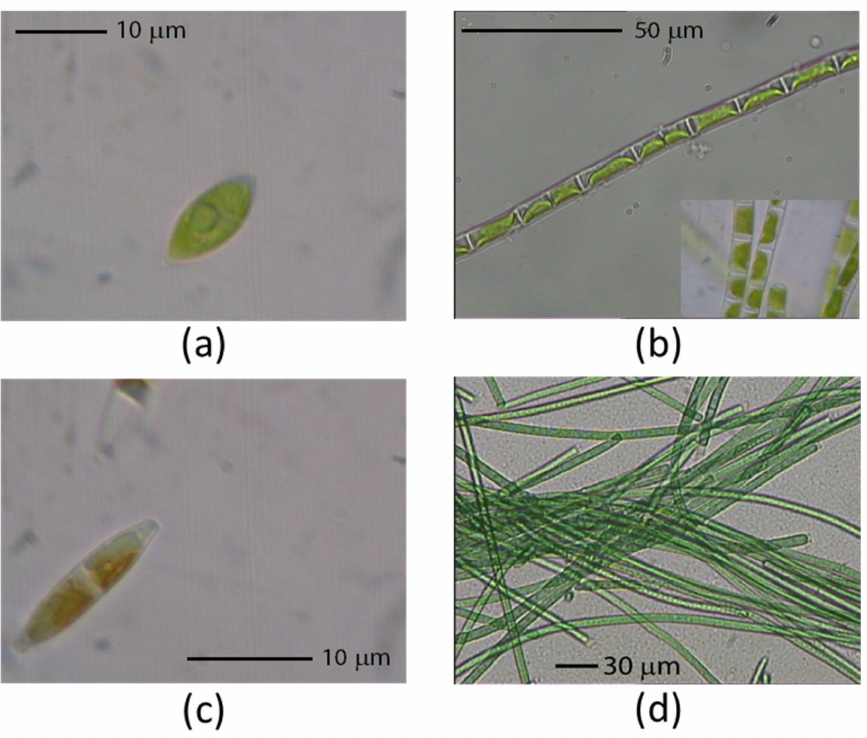
Figure 1. Photographs of the algal species used in this study. ( a ) Oocystis sp. (cell length c.a. 14.7 µ m); ( b ) Klebsormidium flaccidum (cell length c.a. 16.9 µ m); ( c ) Haslea spicula (cell length c.a. 15.8 µ m); ( d ) Microcoleus vaginatus (cell length undetermined). A Leica MDLB microscope with a LEICA MC 170 HD camera and image capture software (IM50 1.20R19) were used for photographs (40 ×